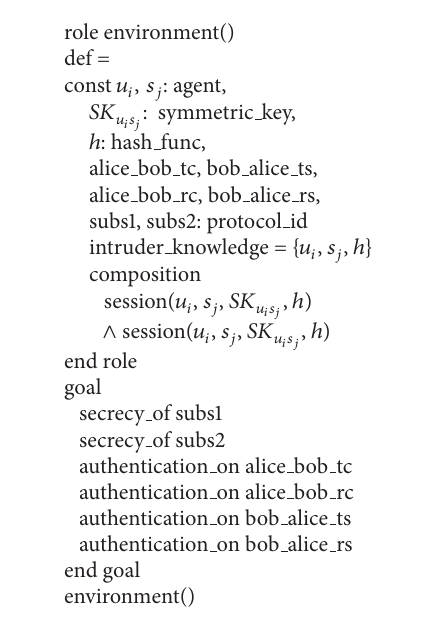
Algorithm 6: Role specification in HLPSL for the goal and environment of our scheme.